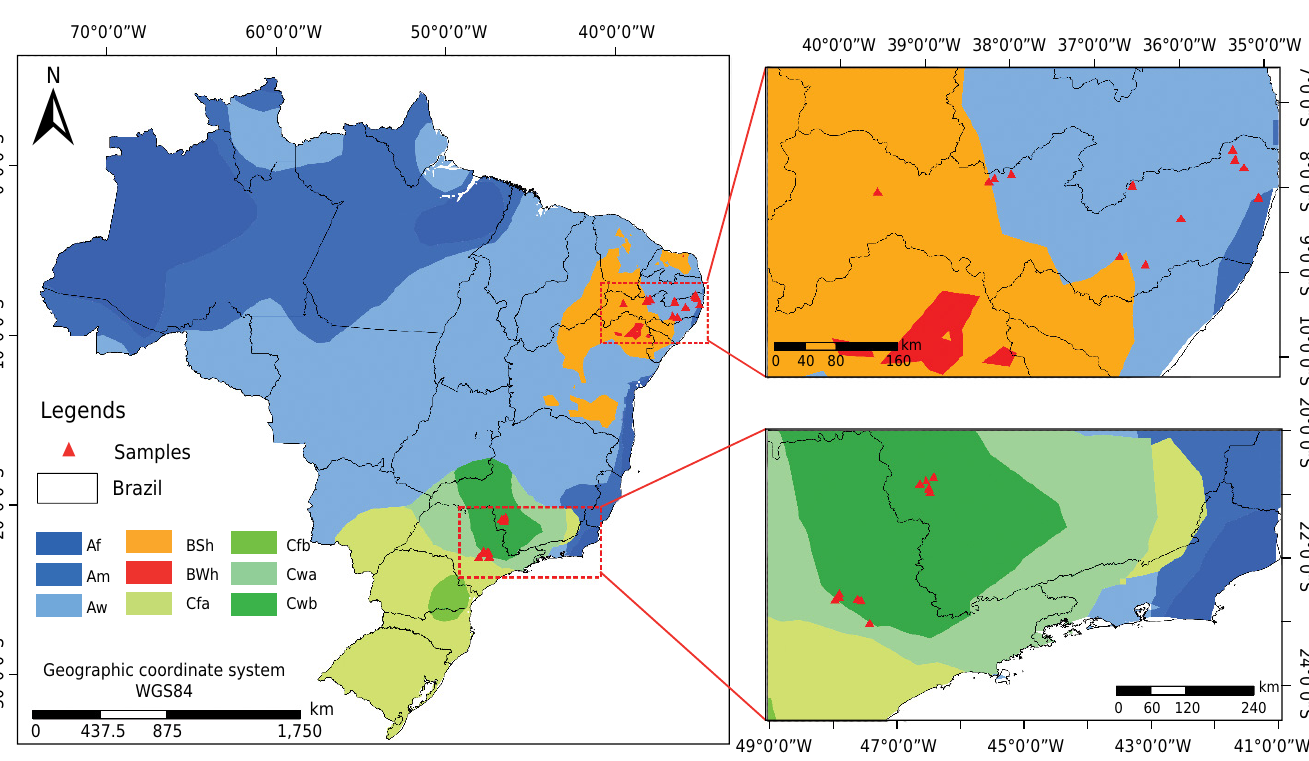
Figure 2. Profiles location and climate types in the two regions sampled. Af – Tropical rainforest climates; Am – Tropical monsoon climate; Aw – Tropical savanna climate; BSh – Hot semi-arid climate; BWh – Hot desert climate; Cfa – Humid subtropical climate; Cfb – Oceanic climate; Cwa – Humid subtropical climate; Cwb – Subtropical highland climate (Peel et al.,